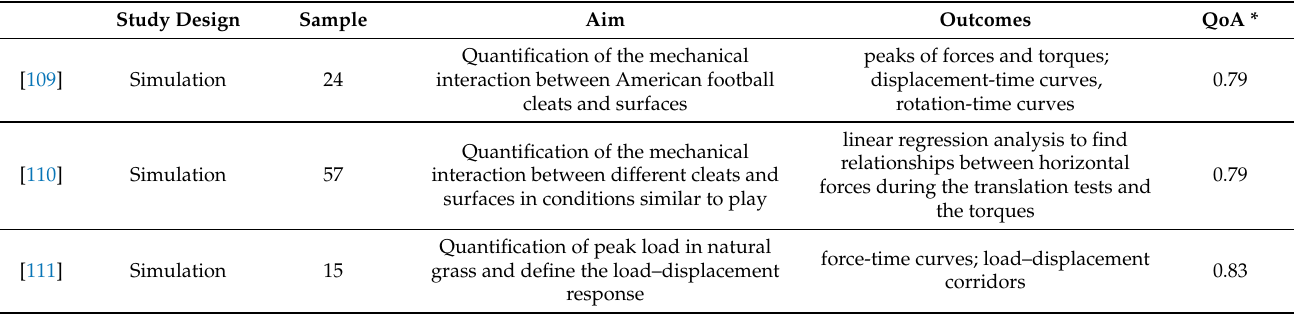
Table 5. Studies regarding the biomechanics of